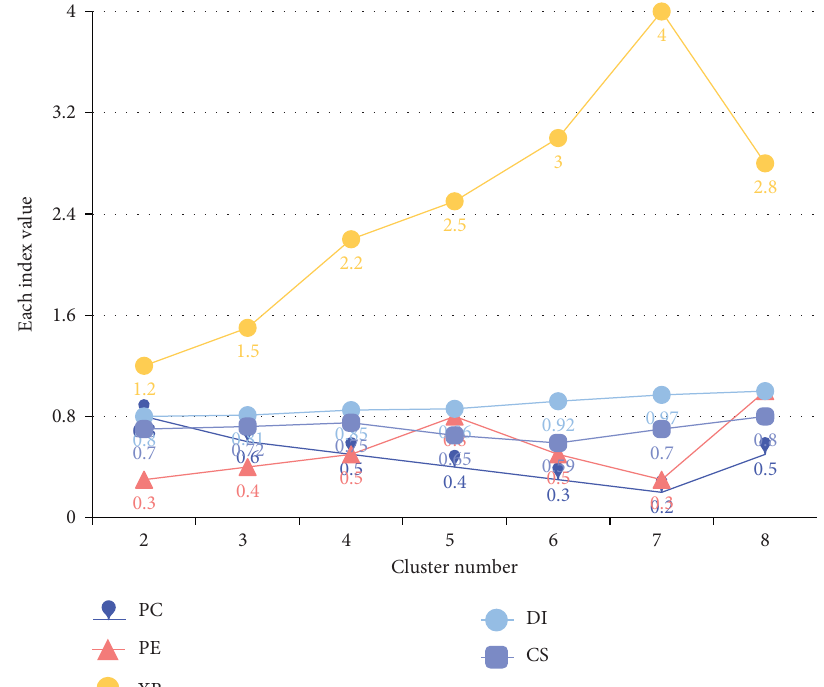
Figure 8: Experimental results of dataset